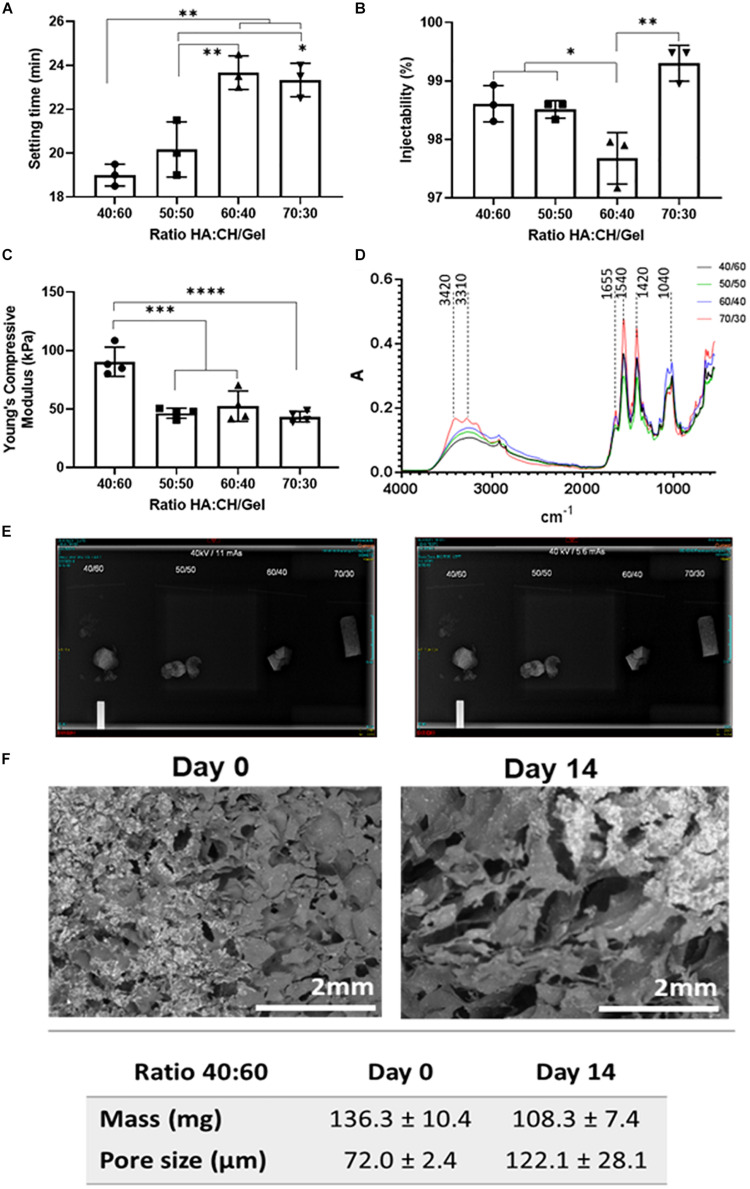
(A) Setting time (in minutes), (B) Injectability as (%), (C) Compressive Young modulus, (D) FTIR-ATR spectra, (E) 40 kV 11 mAs (left) and 5.6 mAs X-Ray (right) Images visible for bone cements at different ratios of hydroxyapatite and Chitosan/Gelatin 40/60, 50/50, 60/40, and 70/30. (F) SEM micrographs of bone cements (40/60) after 14 days incubation in PBS at 37°C. Statistics: *p < 0.05, **p < 0.007, ***p < 0.0007, ****p < 0.0001.